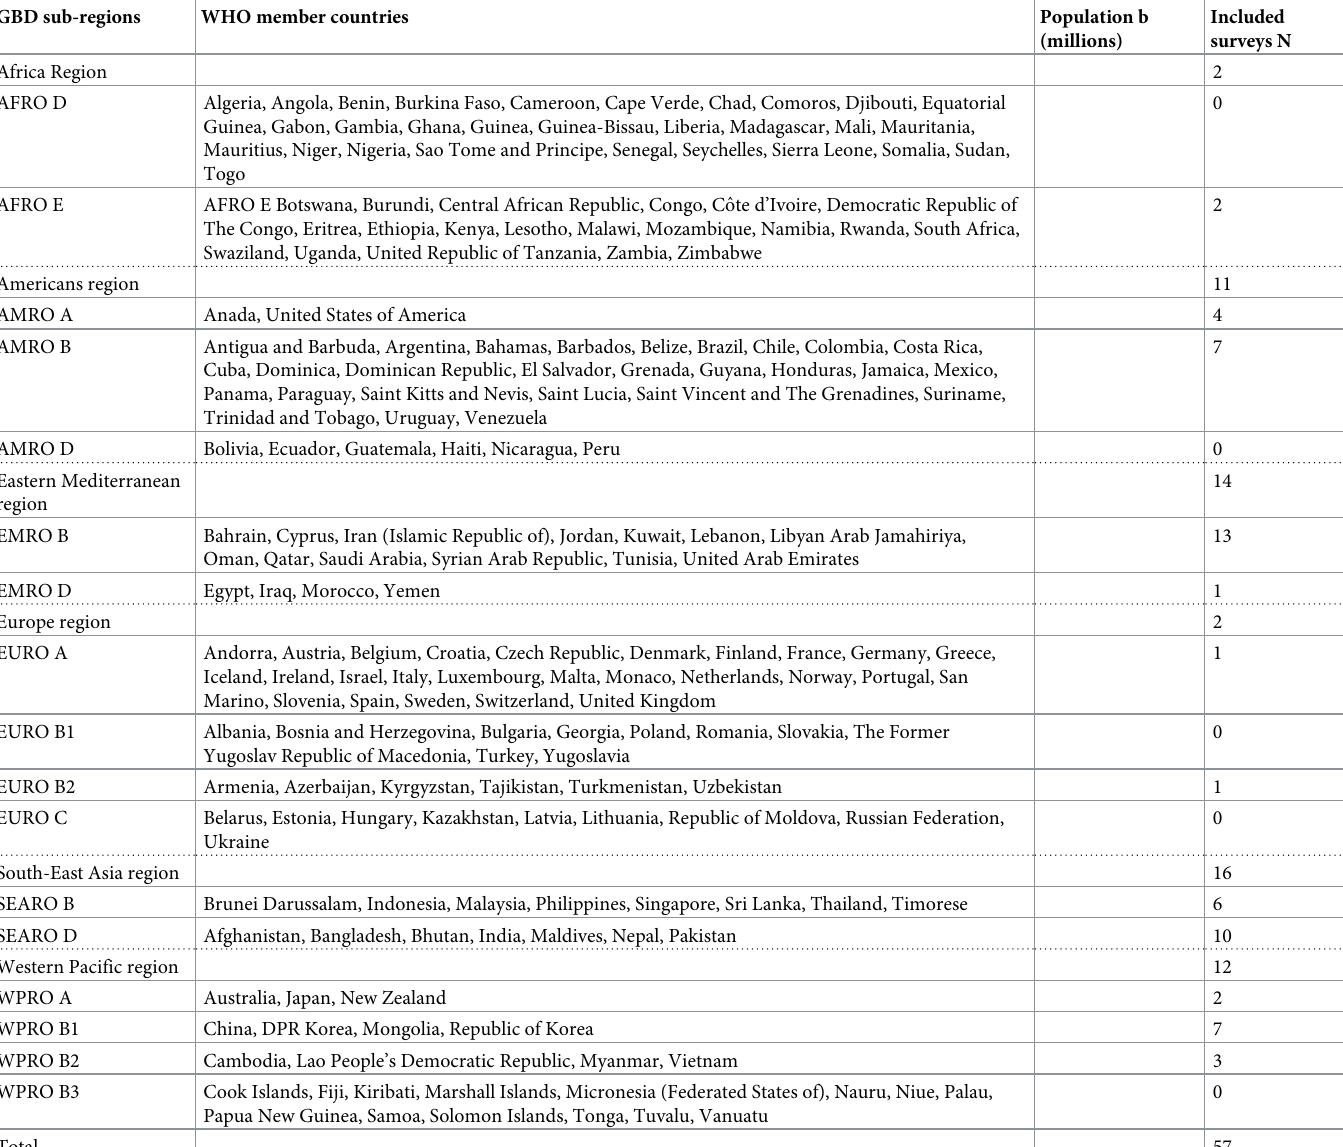
Table 2. Number of included surveys available for Global Burden of Disease (GBD) sub-regions.